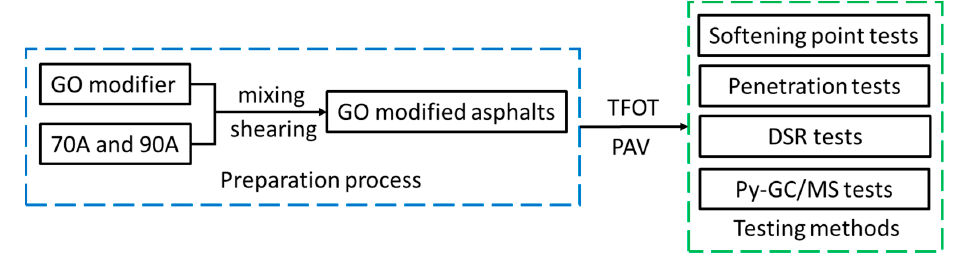
Figure 2. Experimental plan.